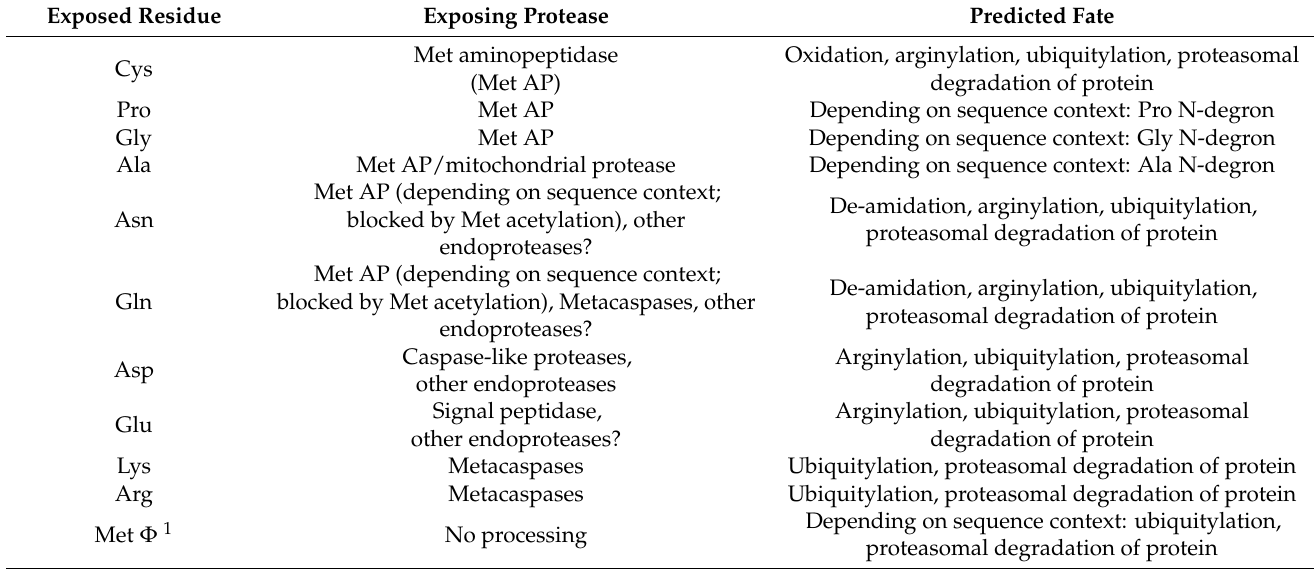
Table 1. Fate of proteins with the indicated amino-terminal